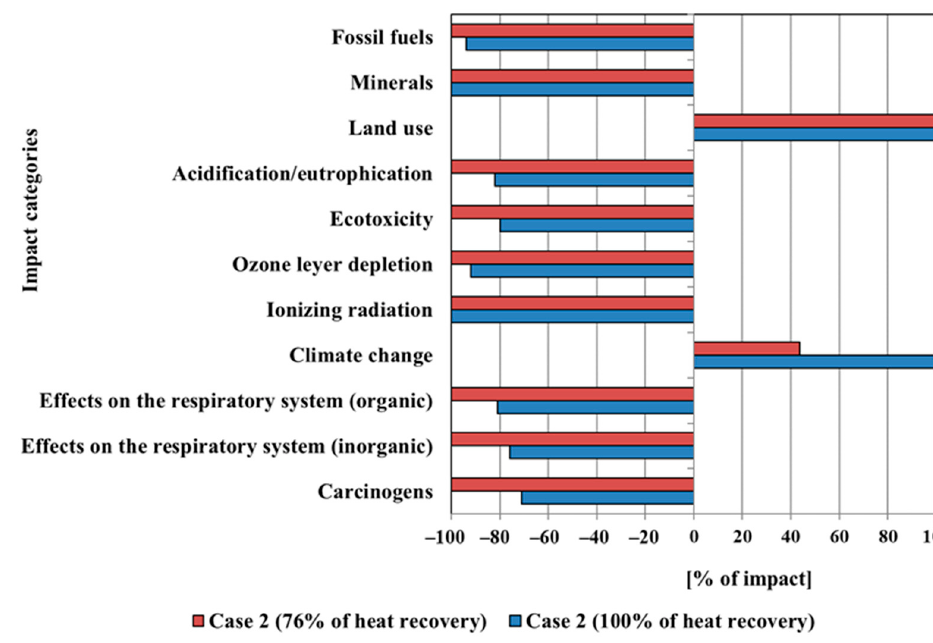
Figure 8. The comparative life cycle analysis results in the in 1 MWh of electricity from the biogas production process obtained in Case 2 with 76% and 100% thermal energy utilization for individual impact categories under the Eco–Indicator 99 method